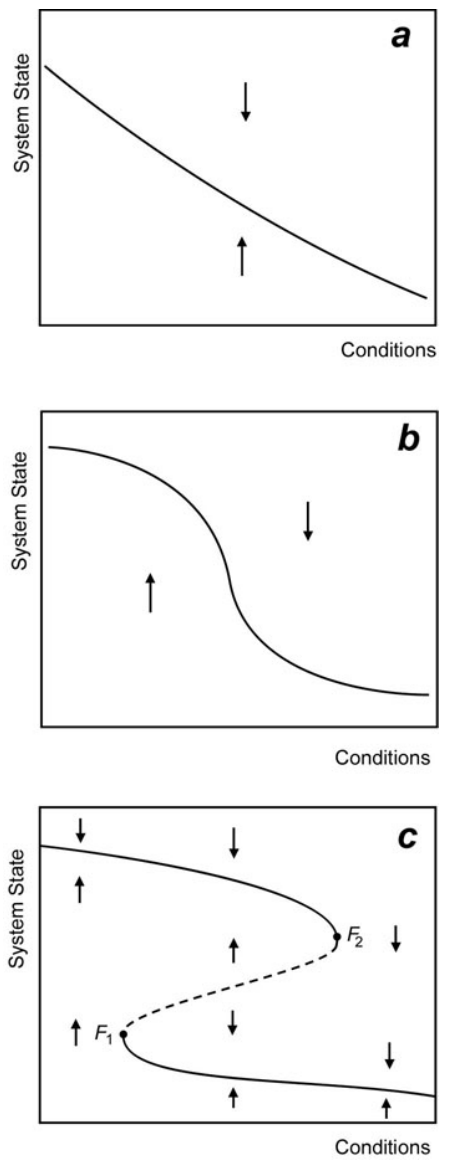
Fig. 1. Schematic representation of possible ways in which the equilibrium state of a system can vary with conditions, such as nutrient loading, exploitation, or a rise in temperature. In panels a and b, only one equilibrium exists for each condition. However, if the equilibrium curve is folded backward (panel c), three equilibria can exist for a given condition. The arrows in the graphs indicate the direction in which the system moves if it is not in equilibrium (i.e., not on the curve). It can be seen from these arrows that all curves represent stable equilibria, except for the dashed middle section in panel c. If the system is pushed away a little bit from this part of the curve, it will move further away instead of returning. Hence, equilibria on this part of the curve are unstable and represent the border between the basins of attraction of the two alternative stable states on the upper and lower